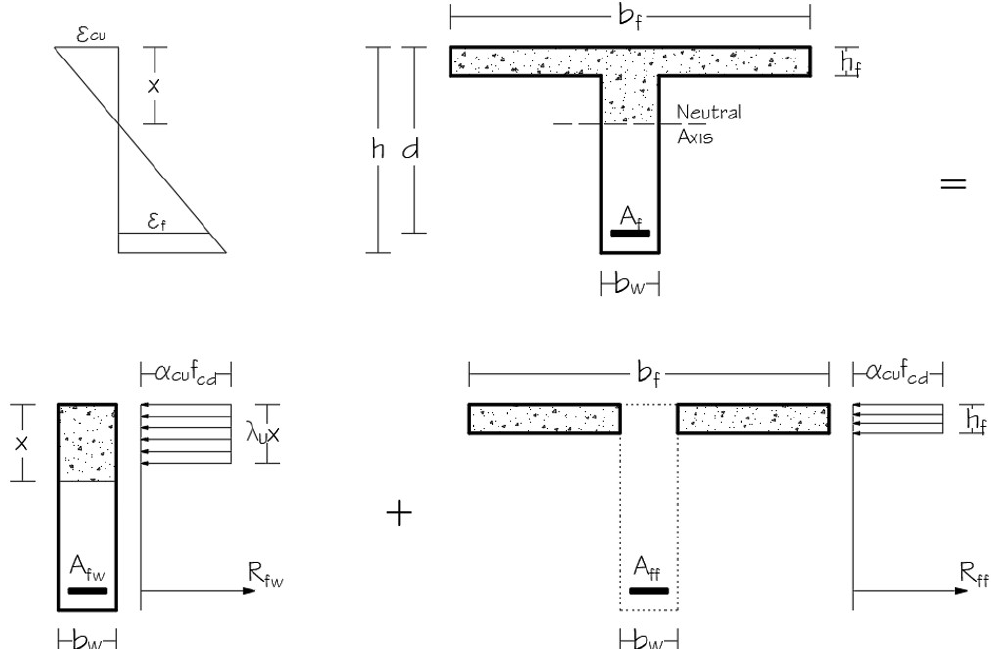
Figure 9. Equilibrium and compatibility of a compression-controlled section whose stress block reaches the web